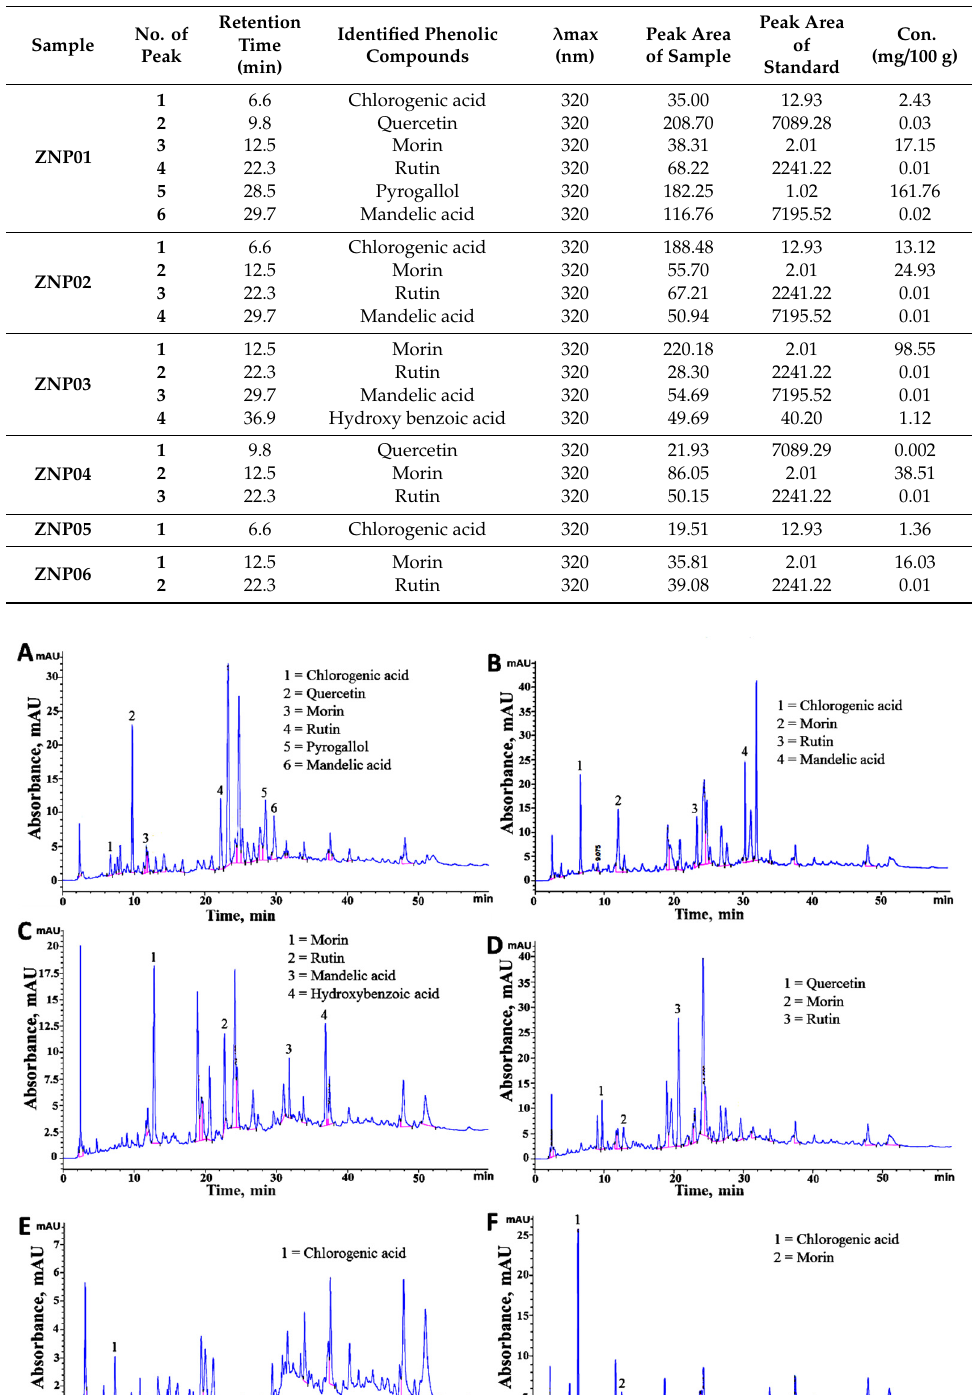
Table 2. Characterization and quantification of phenolic compounds in di ff erent genotypes of Z. nummularia (Burm. f.) crude methanol extract by HPLC analysis.